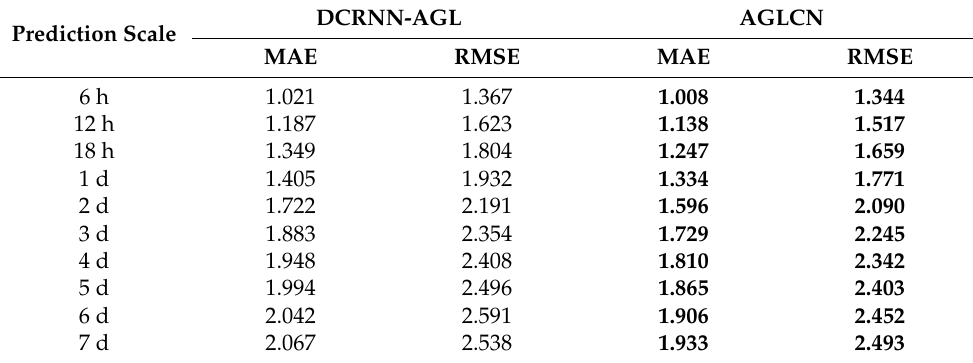
Table A1. The results of forecasting methods for 40 nodes.